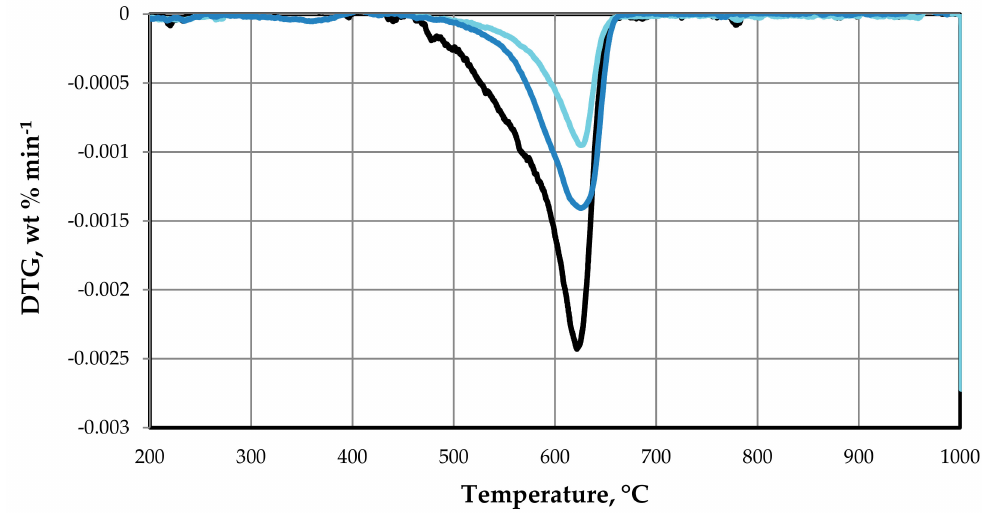
Figure 13. DTG signals of the carbon formed at 700 ◦ C and S/C: 2 ( ), 4 ( ), and 6 (